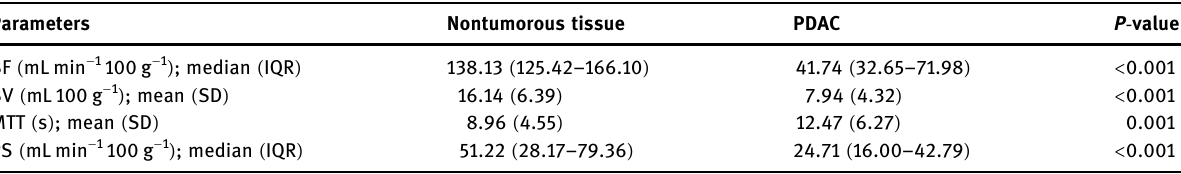
Table 1: Perfusion CT parameters with SD in normal parenchymal tissue and PDAC